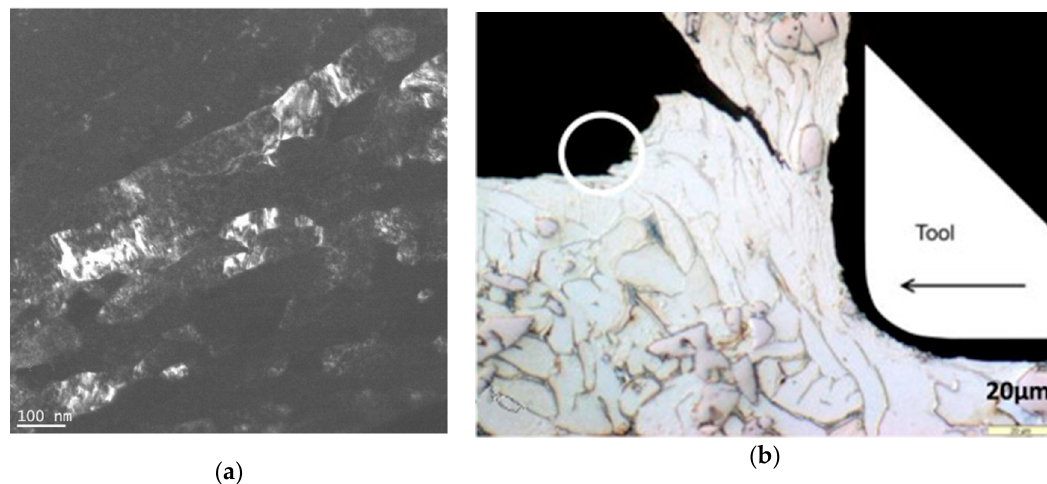
Figure 4. ( a ) Darkfield imaging of sub-grains inside the adiabatic shear band (ASB); ( b ) Sign of crack initiation at the free surface ahead of the tool (v c = 60 m/min) [38].